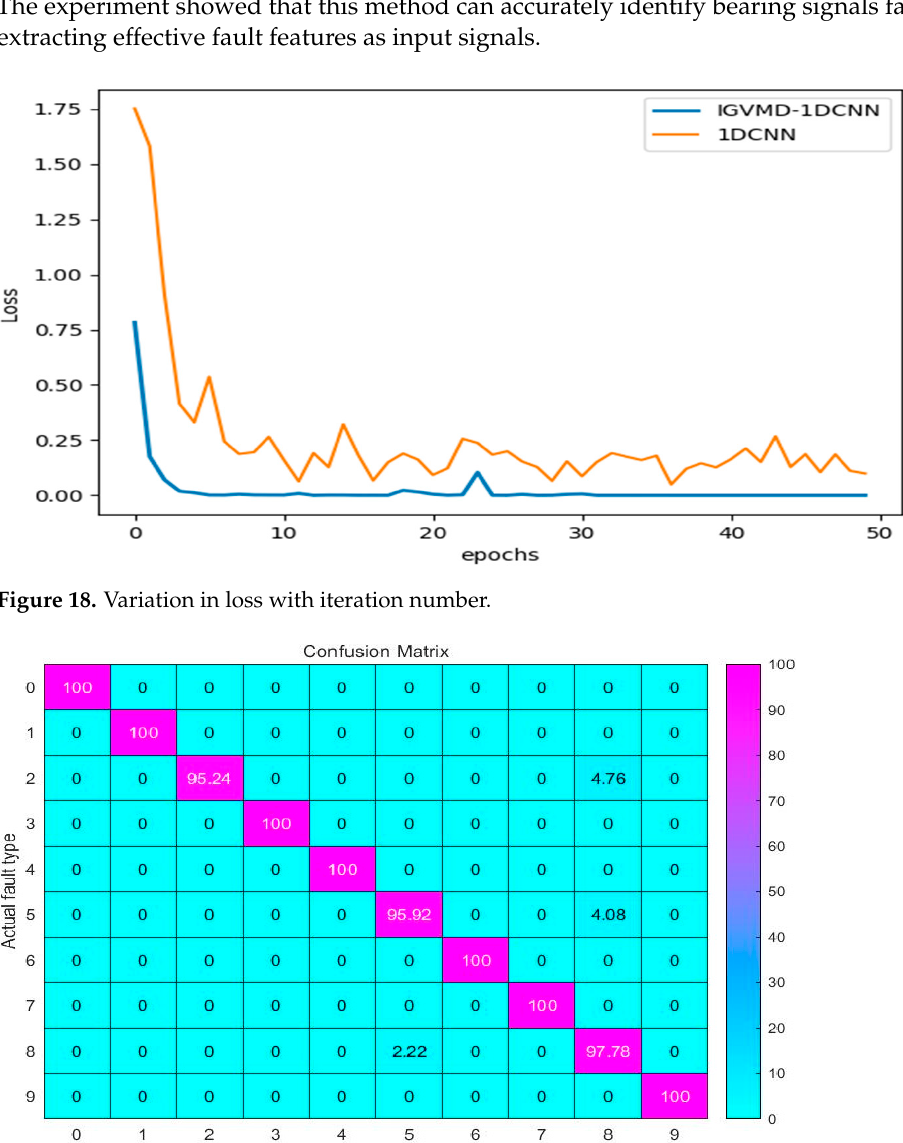
Figure 17. Variation in accuracy with iteration number.